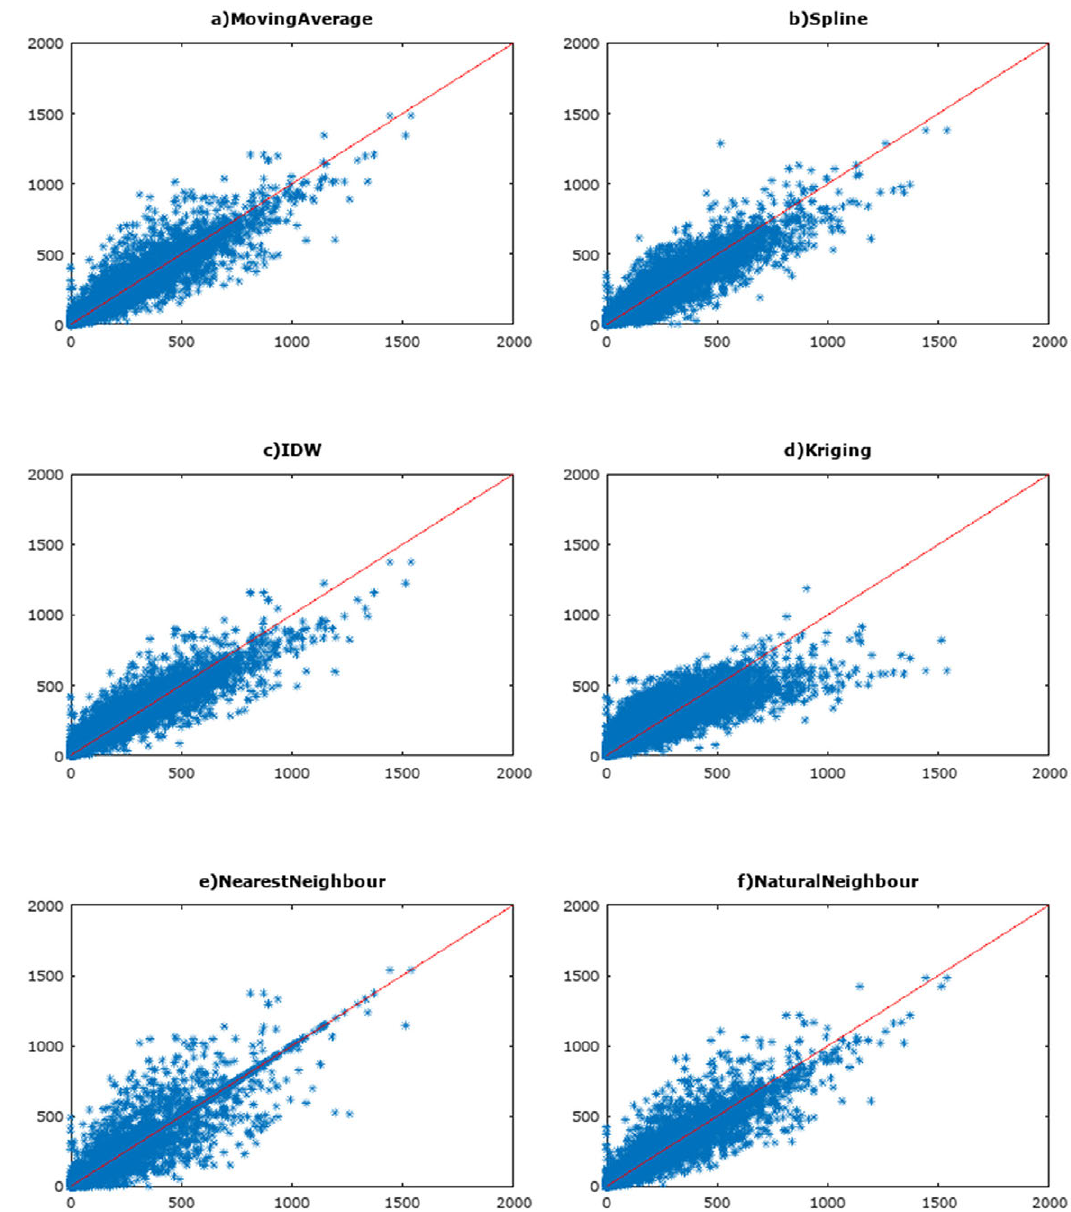
Fig. 7. Selection of interpolation techniques, a) Moving Average, b) Spline, c) IDW, d) Kriging, e)